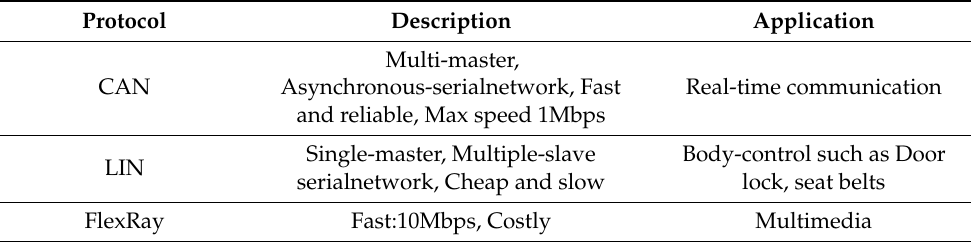
Table 1. Classification of the in-vehicle